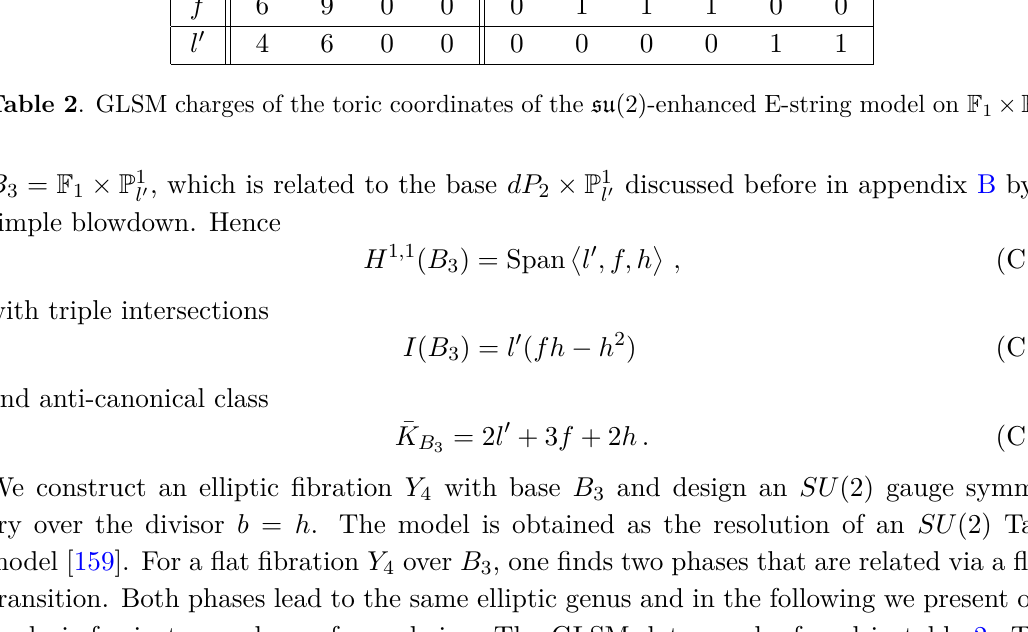
Table 2 . GLSM charges of the toric coordinates of the su (2) -enhanced E-string model on F 1 × P 1